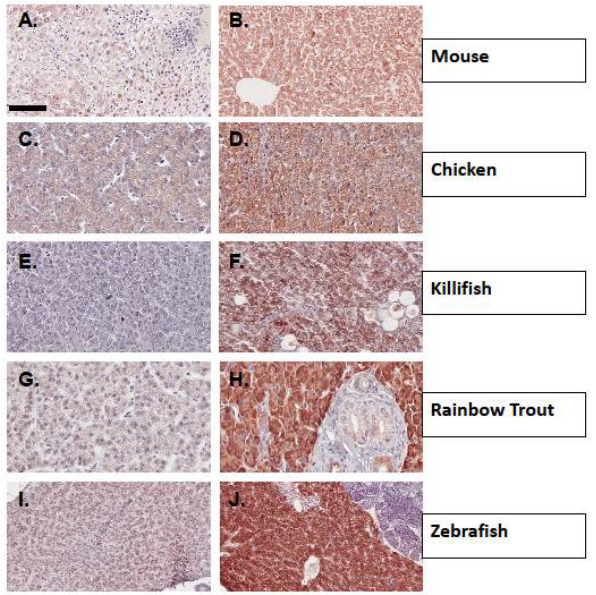
Figure 3. Immunohistochemical detection of CYP1A protein expression using mAb CRC4 in liver tissues from representative vertebrates. ( A ). Control mouse liver; ( B ). Liver from a PCB-126 treated mouse; ( C ). Control chicken embryo liver at 18 days post fertilization (DPF); ( D ). Liver from a crude oil vapor-exposed chicken embryo at 18 DPF; ( E ). Liver from CYP1A recalcitrant Gulf killifish; ( F ). Liver from Gulf killifish collected from a crude oil exposed site; ( G ). Control Rainbow trout liver; ( H ). Liver from a β-NF-exposed rainbow trout; ( I ). Control zebrafish liver; ( J ). Liver from PCB-126 treated zebrafish. ( A , B) are 20× magnification, scale bar = 100 µm ( C – J) are 40× magnification, scale bar = 50 µm. Details of tissue sources, experimental conditions, and procedures are found in Methods and Table 2.